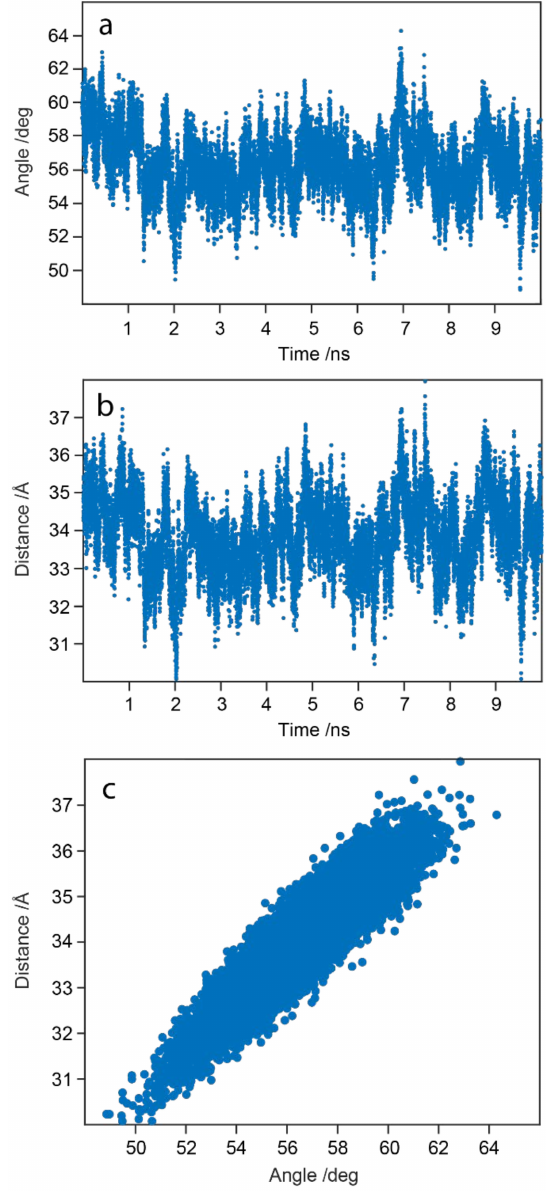
Figure 11. ( a ) Angle variation over time between the C α atoms of His62 (N-domain), Lys248 (C- domain) and Gly168 (hinge region) and ( b ) distance fluctuations over time between the C α atoms of His62 and Lys248 during the 10-ns MD calculation. ( c ) Scatter plot of the two variables against each